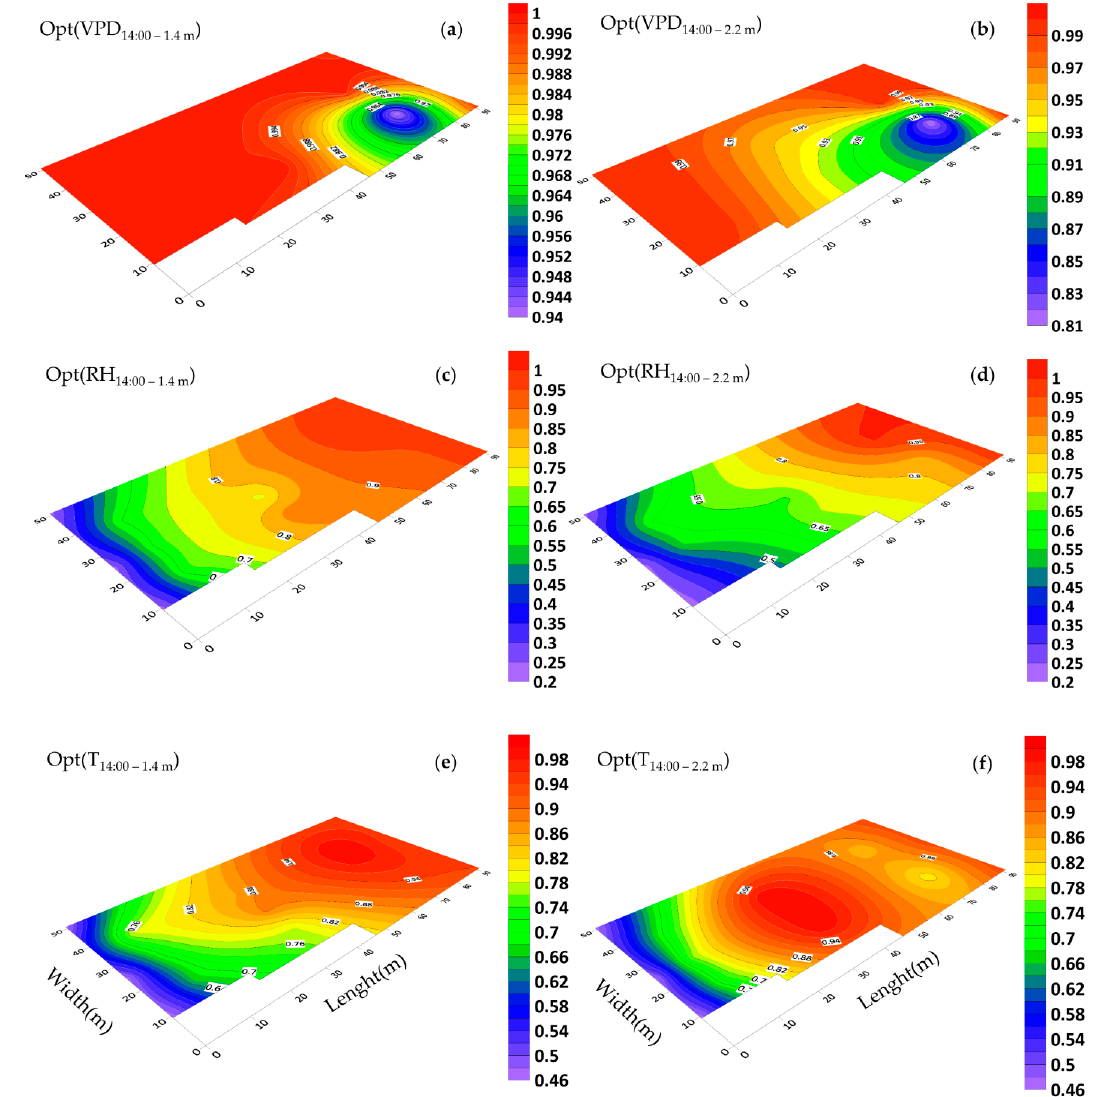
Figure 14. Optimality degrees range and distribution on a horizontal plane at 14:00 in 1.4 m and 2.2 m elevations on 10 January 2018. OptDeg(VPD) at 1.4 m ( a ) and 2.2 m ( b ); OptDeg(RH) at 1.4 m ( c ) and 2.2 m ( d ); and, OptDeg(T) at 1.4 m ( e ) and 2.2 m ( f ). Scales display the range of optimality degrees variation.